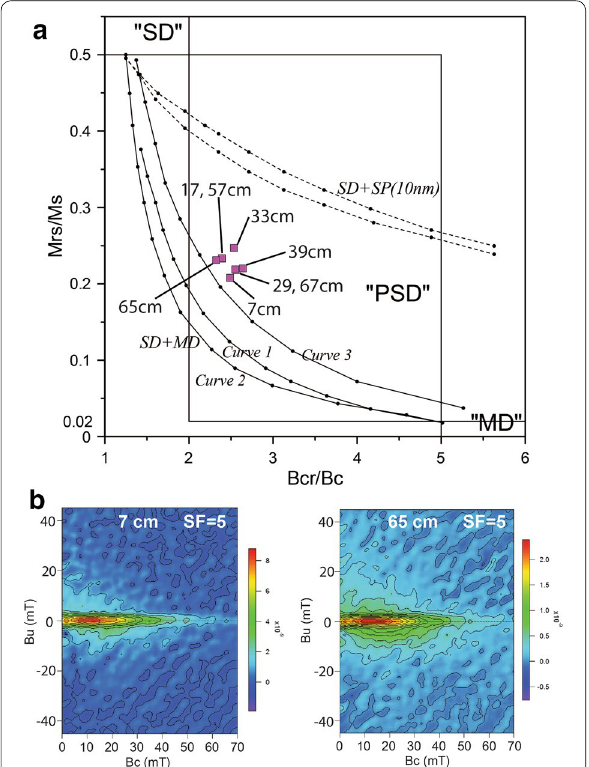
Fig. 10 a Day plot (Day et al. 1977) of hysteresis parameters on selected subsamples at different horizons (from 7 to 67 cm depth of the GSDS1 profile). Solid lines with dots denote theoretical curves 1–3 for mixtures of SD and MD grains, and dashed lines with dots indicate theoretical curves for mixtures of SD and SP (10 nm in size) grains (Dunlop 2002a, b). b Typical FORC diagrams for 7 and 65 cm